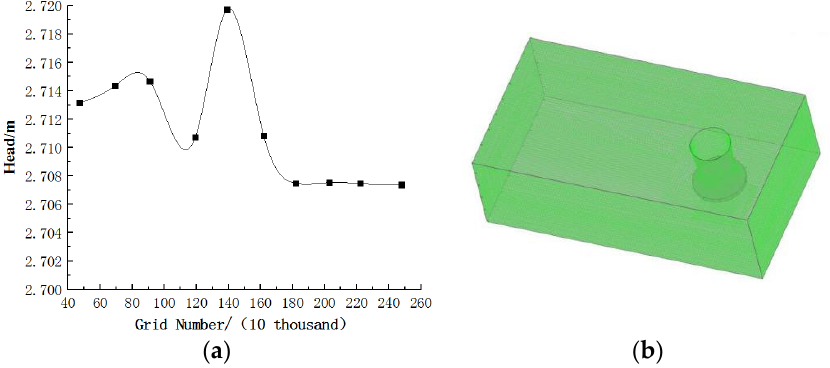
Figure 4. Grid independence and grid partition. ( a ) Grid independence and ( b ) grid of